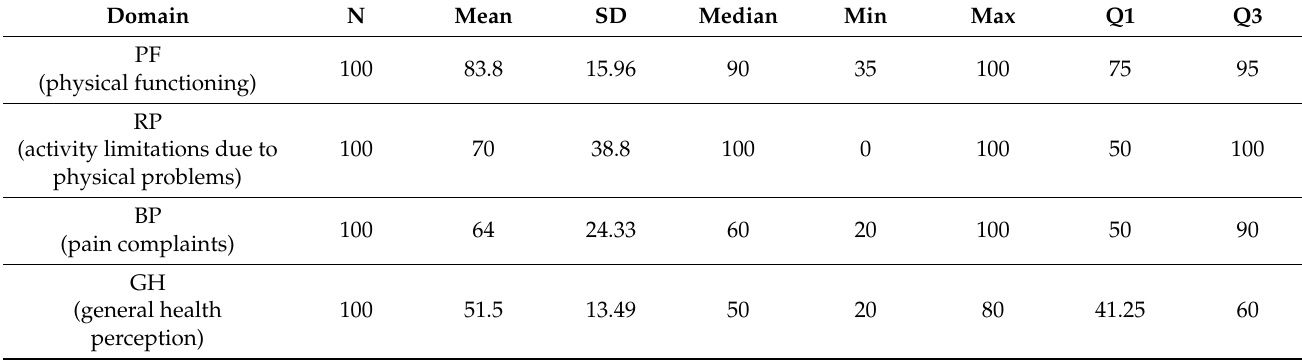
Table A1. Mean SF-36 results in the study